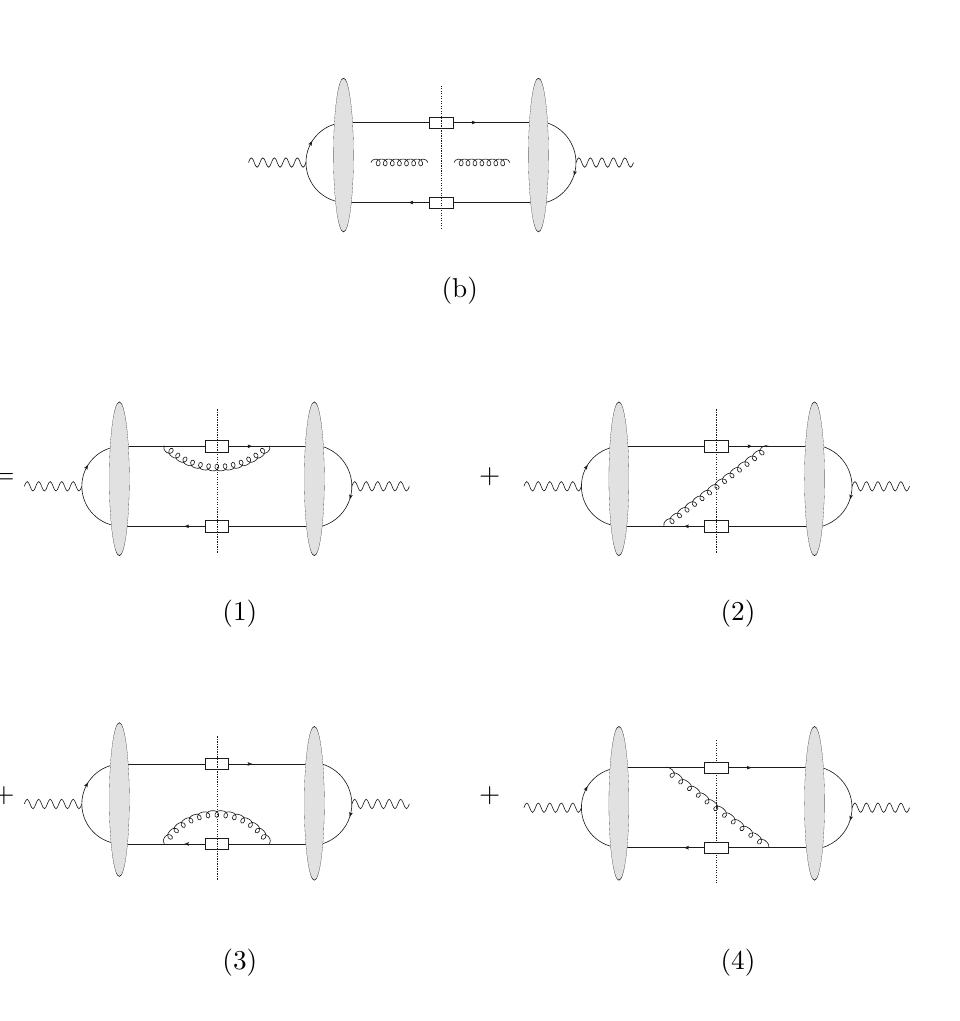
Figure 6 . NLO cross-section in the case of fragmentation from the quark and the antiquark. We explicitly isolate the diagrams which contain divergences. Diagram (1) contains a collinear divergence between the fragmenting quark and the gluon as well as a soft gluon divergence. Diagram (2) contains a soft gluon divergence. Diagram (3) contains a collinear divergence between the fragmenting antiquark and the gluon as well as a soft gluon divergence. Diagram (4) contains a soft gluon divergence. By “finite terms”, here, we mean all diagrams in which the gluon crosses the shockwave at least